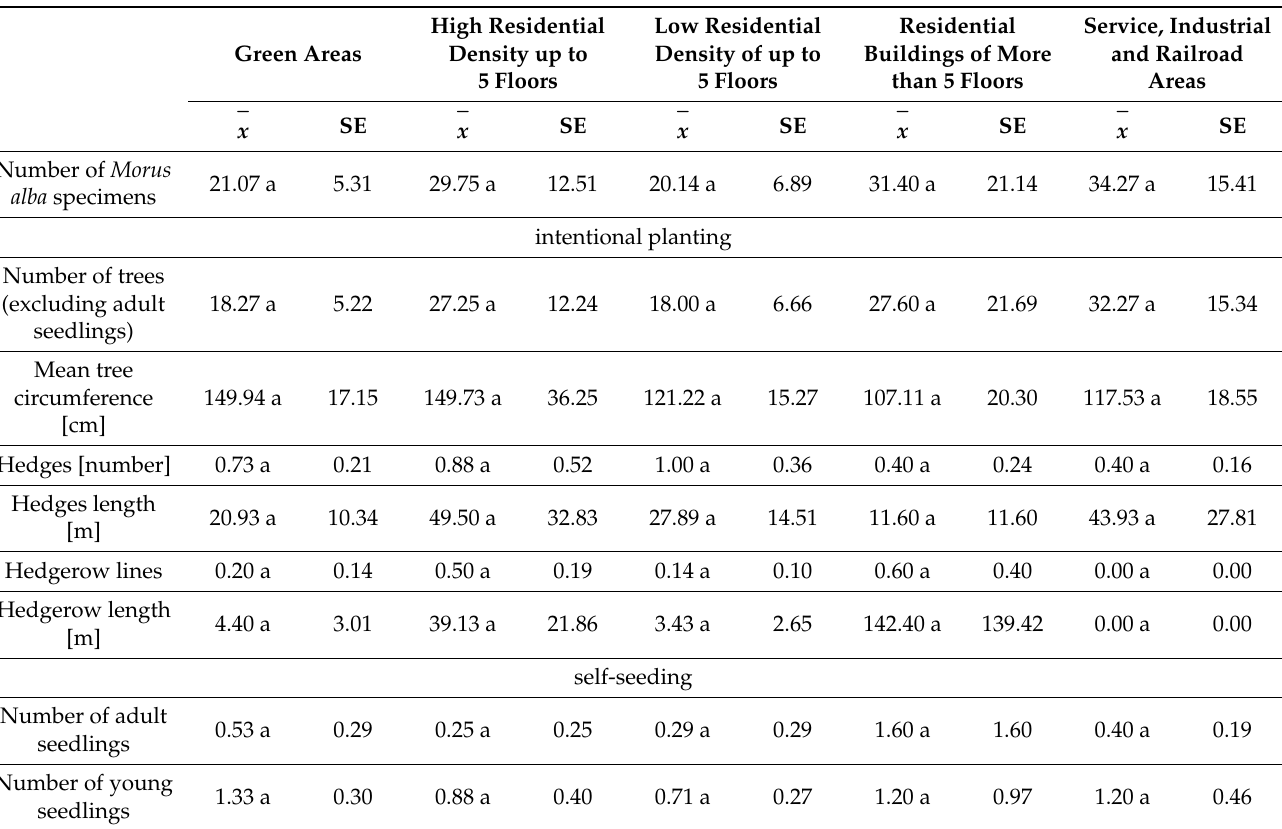
Table 1. Mean values along with standard errors of parameters describing the natural (self-seeding) and artificial (intentional planting) of Morus alba . Different letters (a, b) indicate significant differences obtained after the Tukey’s test or Kruskal–Wallis test ( p ≤ 0.05).